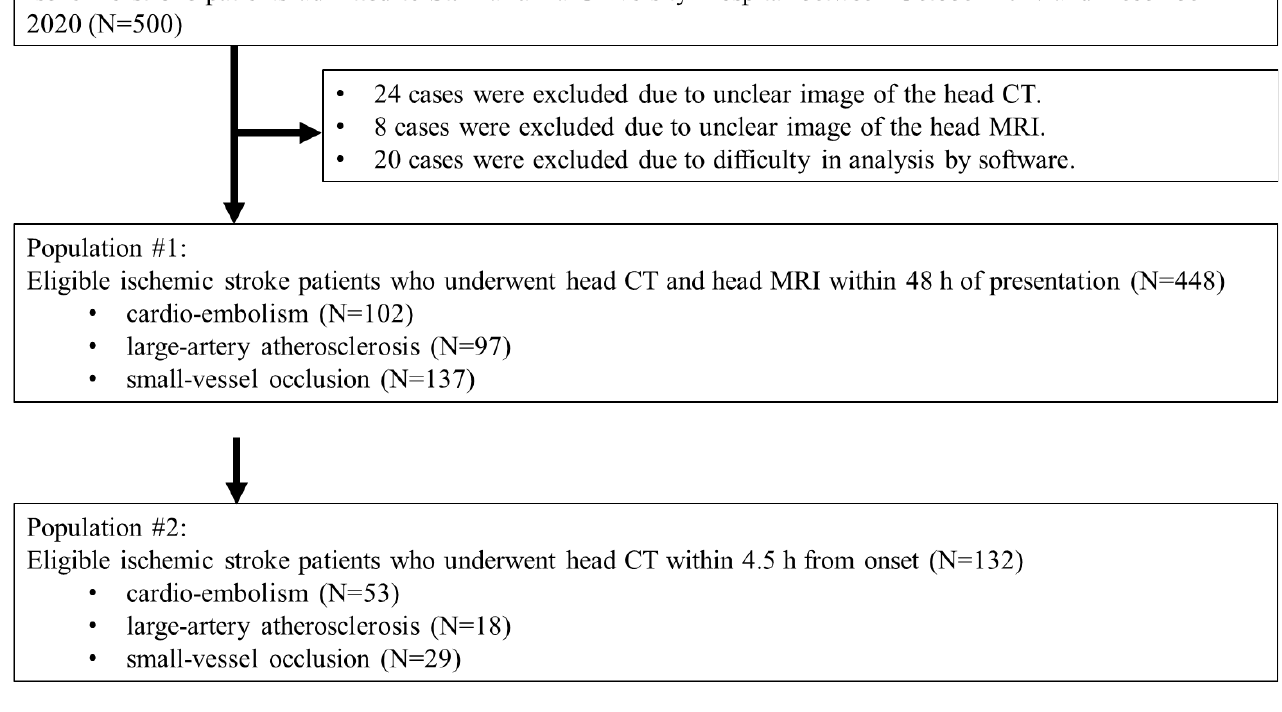
Figure 2. Study flow chart.